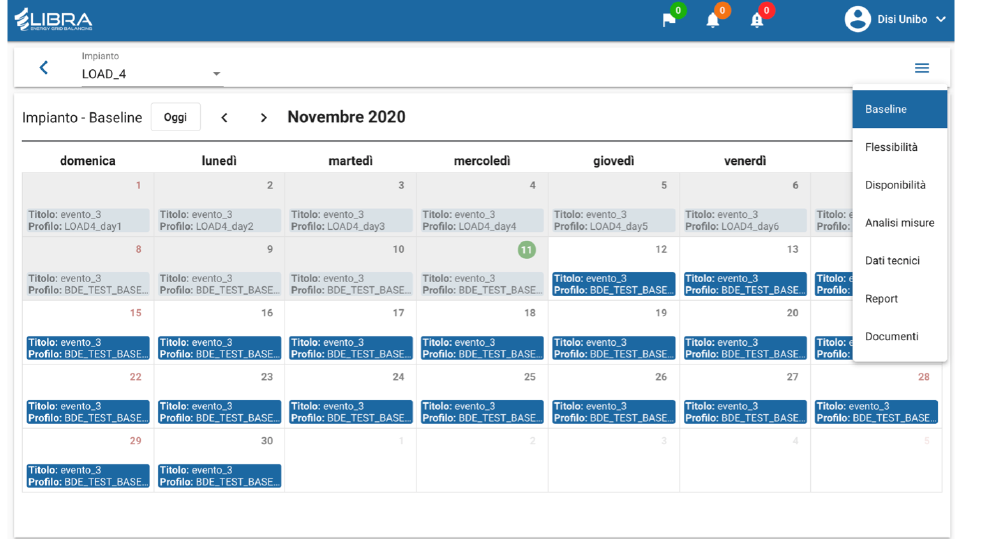
Figure 5. Example of available data for a component on LIBRA